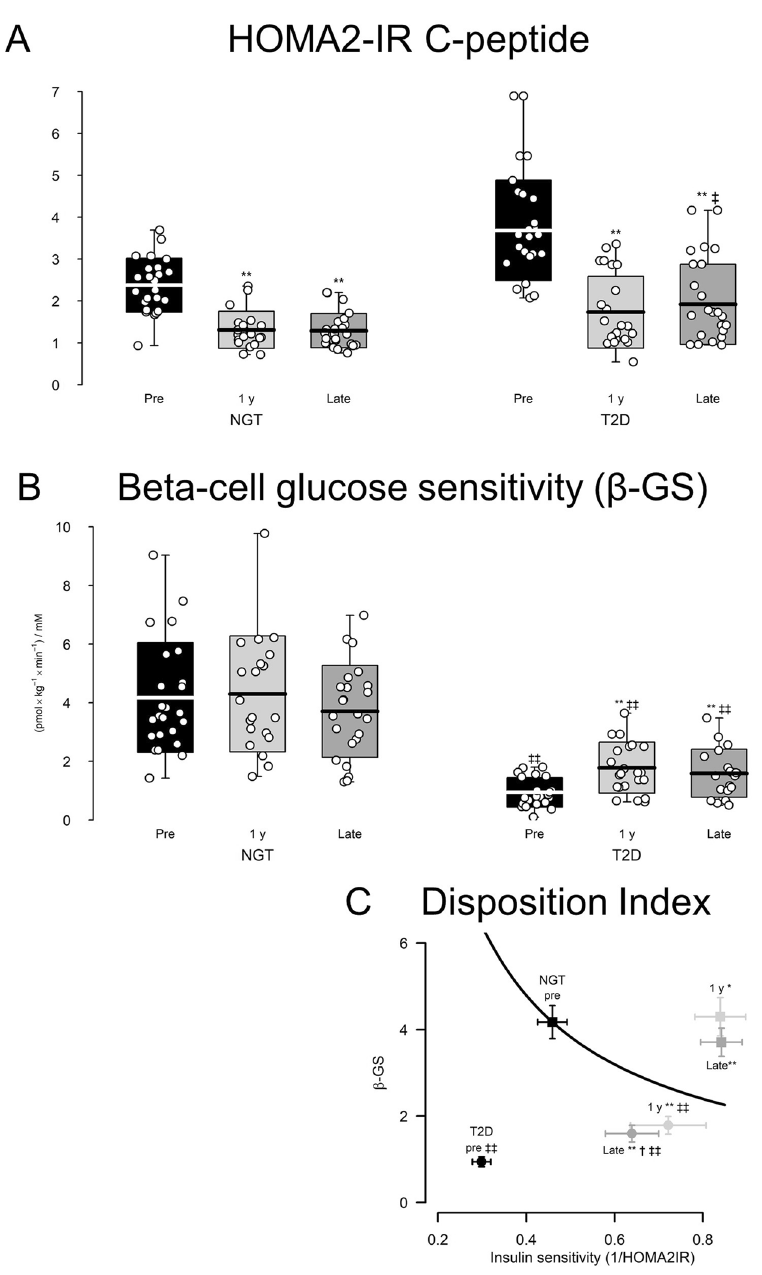
Figure 3. Effect of RYGB surgery on measures of glucose metabolism in T2D and NGT subjects. ( A,B ) Data are mean ± standard deviation, individual data points are indicated. Arrows indicate minimum and maximum data points. ( C ) Data are mean ± SEM. * p < 0.05 vs pre, ** p < 0.001 vs pre; † p < 0.05 vs 1 y, †† p < 0.001 vs 1 y; ‡ p < 0.05 vs NGT, ‡‡ p < 0.001 vs NGT at corresponding time